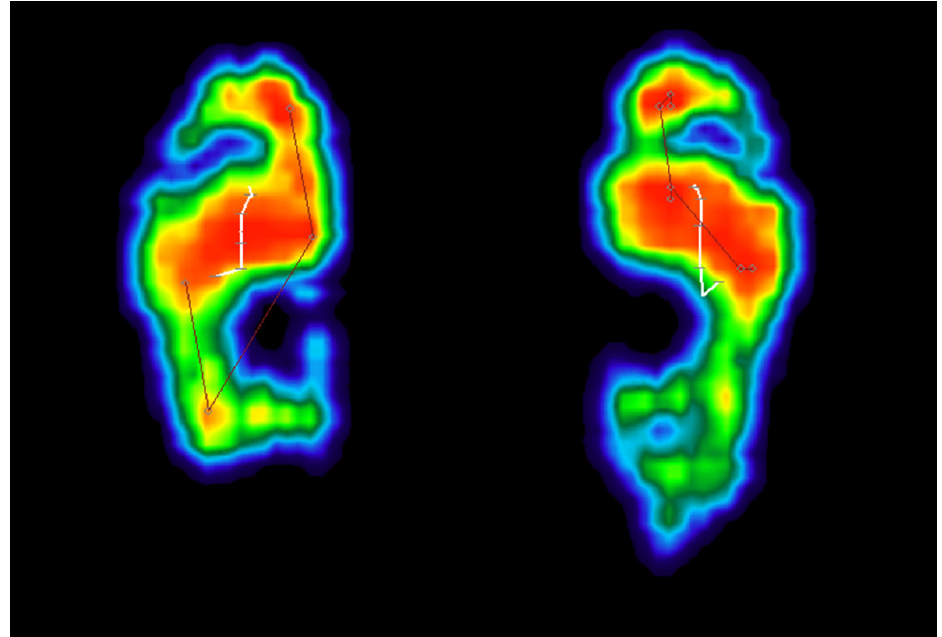
Figure 5. Example of foot plantar pressure global image of left and right feet during a running trial. There is a clear difference between the two feet in the plantar surface that is touching the ground.